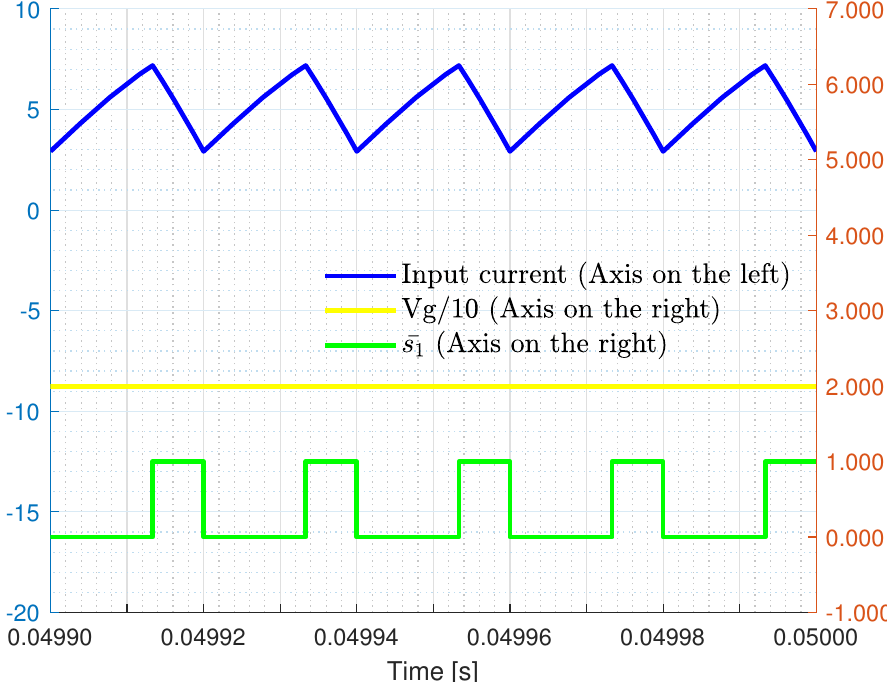
Figure 13. From the top to the bottom: input current I g (blue trace), input voltage V g (yellow trace), and switching signal ¯ s 1 (green trace) of DDSB.